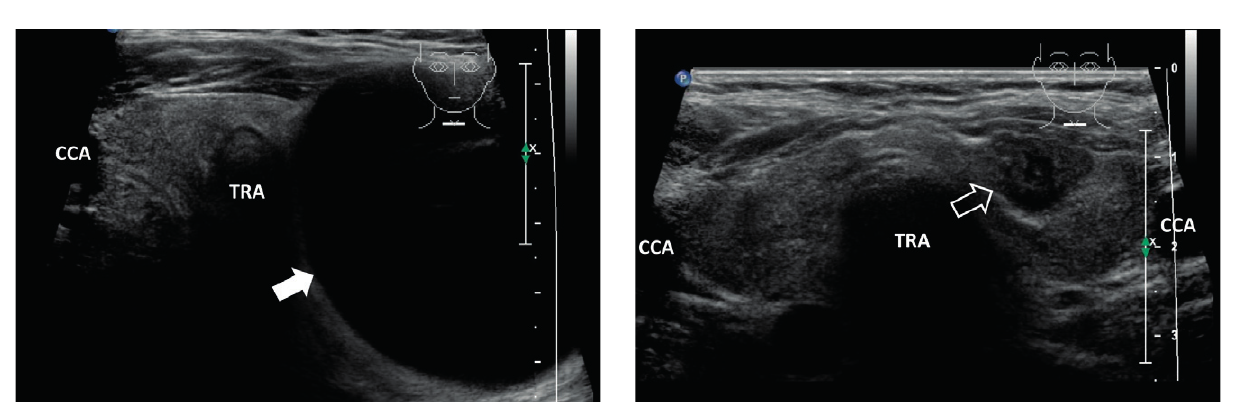
Fig. 1a. An 81–year–old woman with a one month palpable resistance on the neck.